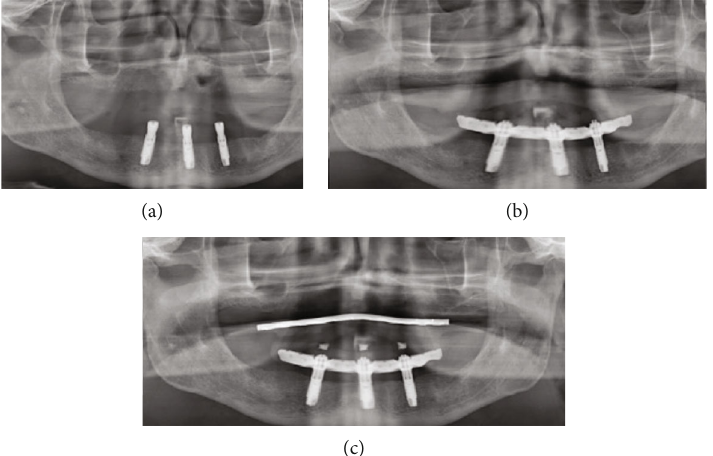
Figure 9: The OPT was taken immediately after the surgery (a), at six months (b), and during the last control visit (30